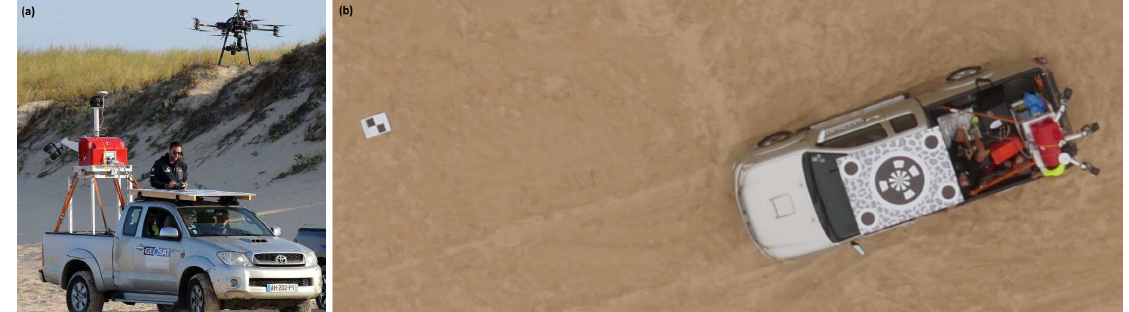
Figure 2. MLS and UAS systems. ( a ) MLS system mounted on a 4WD car and UAS during its take off (Photo courtesy of Denis Lherm, Sud Ouest ). ( b ) UAS view of the MLS roof-mounted optical target and a GCP (A4 size